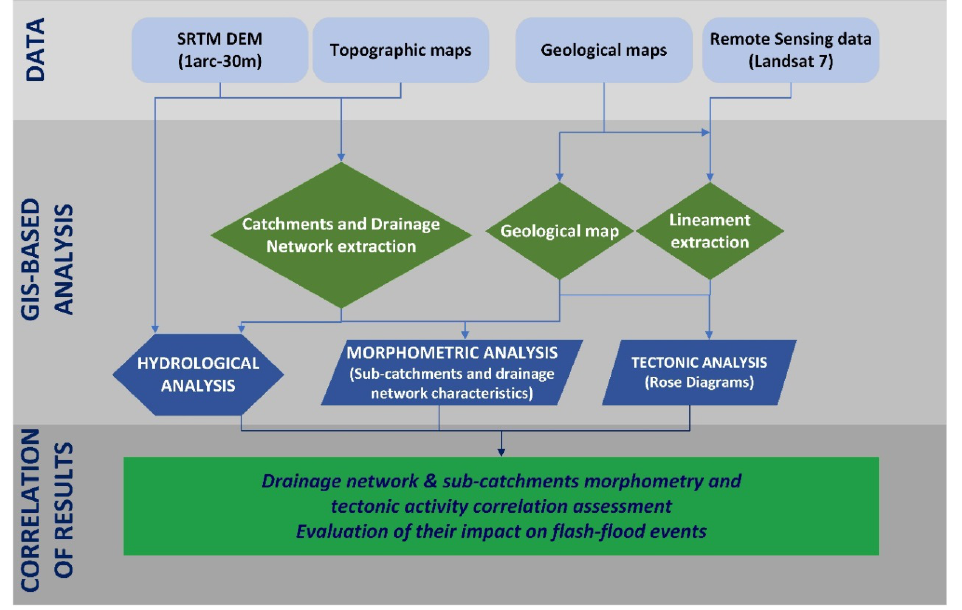
Figure 4. Methodology flowchart.